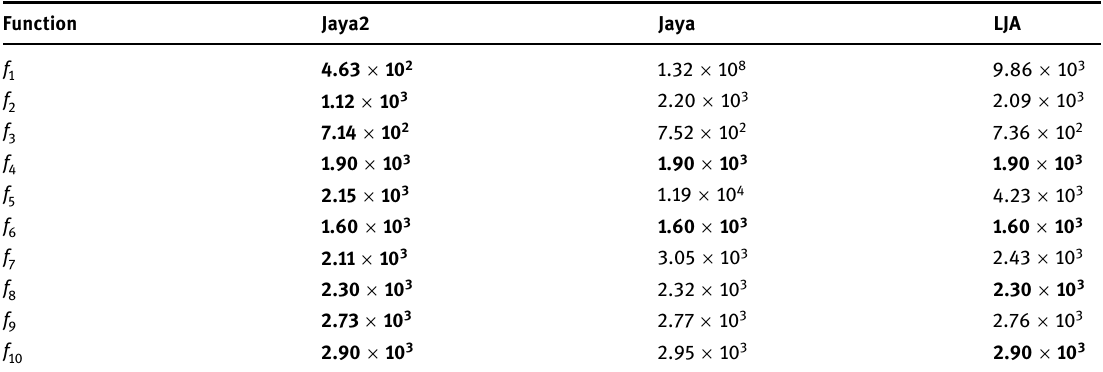
Table 5: The CEC 2020 ( = D 10 ) median function values achieved by Jaya2, Jaya, and LJA over 30 runs and 100,000 function evaluations Function